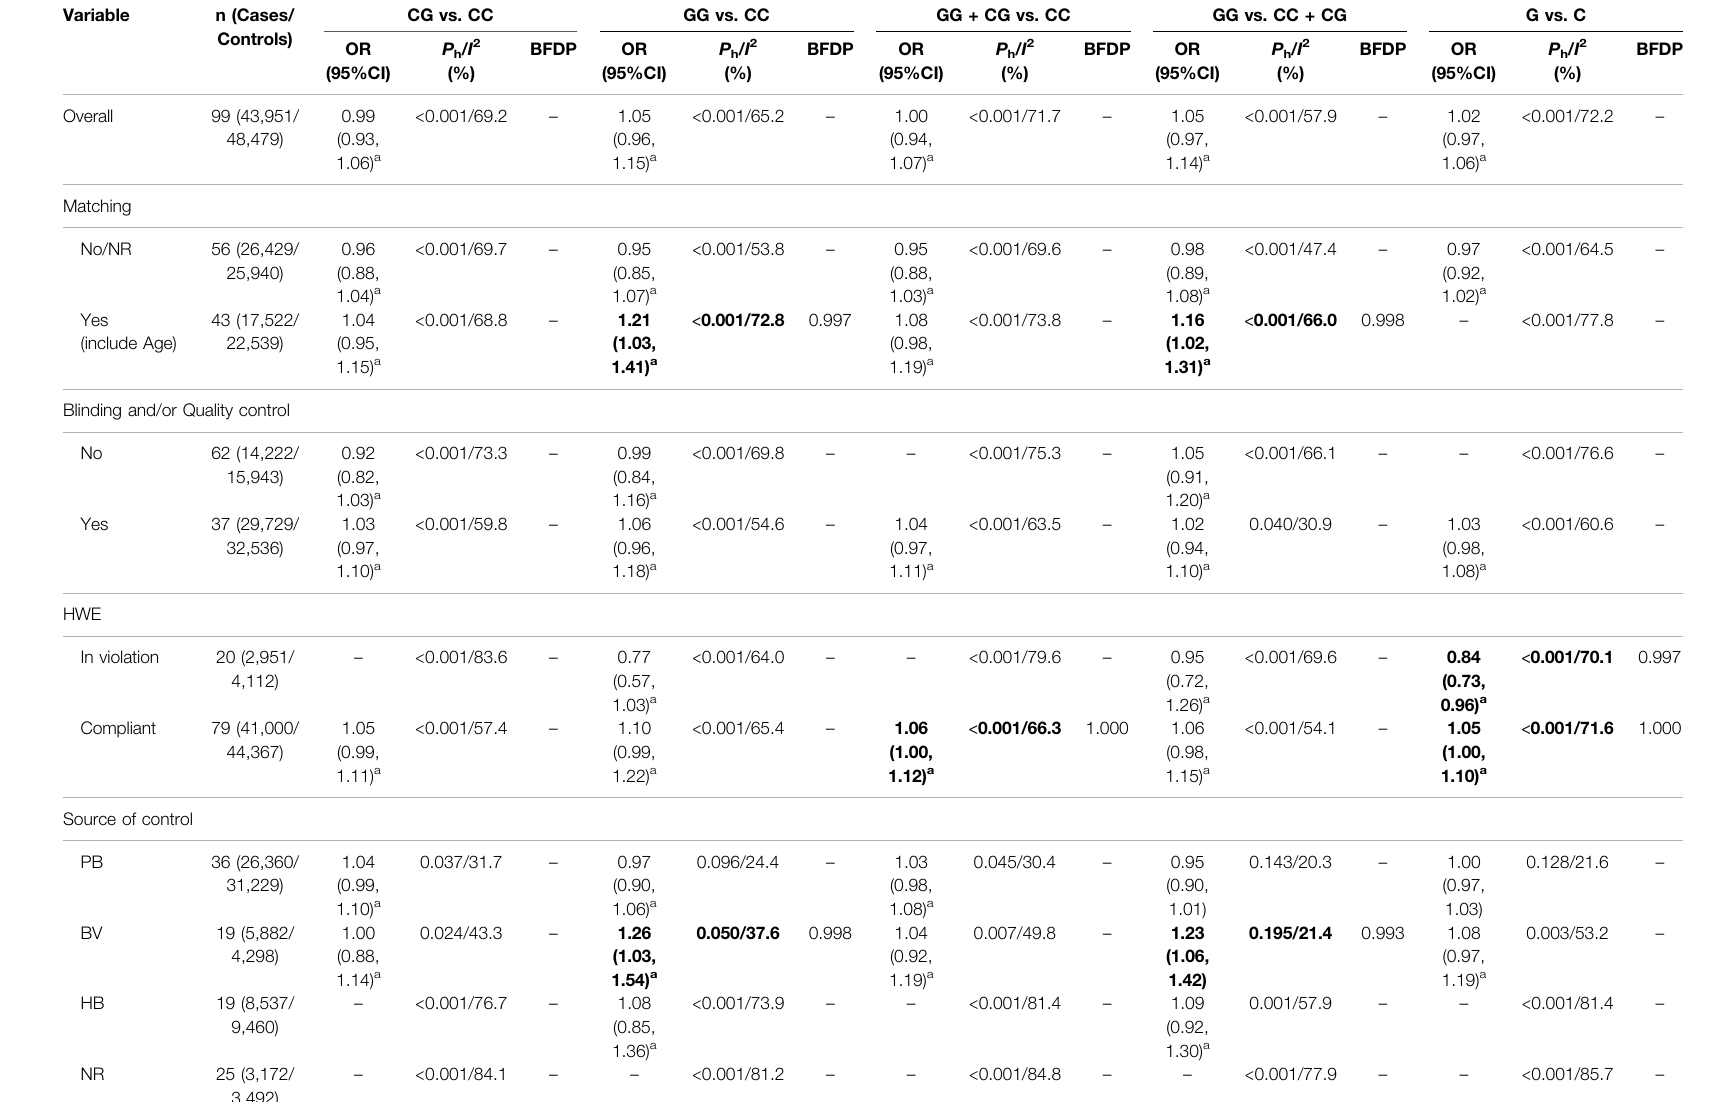
TABLE 2 | Pooled results on the association between the TP53 codon 72 (rs1042522) polymorphism and BC